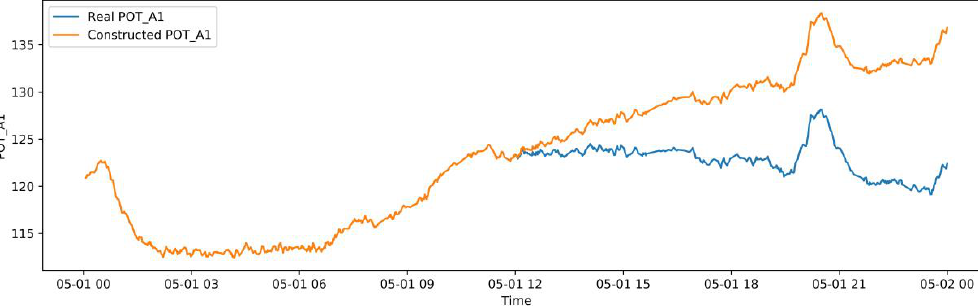
Figure 15. Constructed POT_A1 with linear cumulative drift.